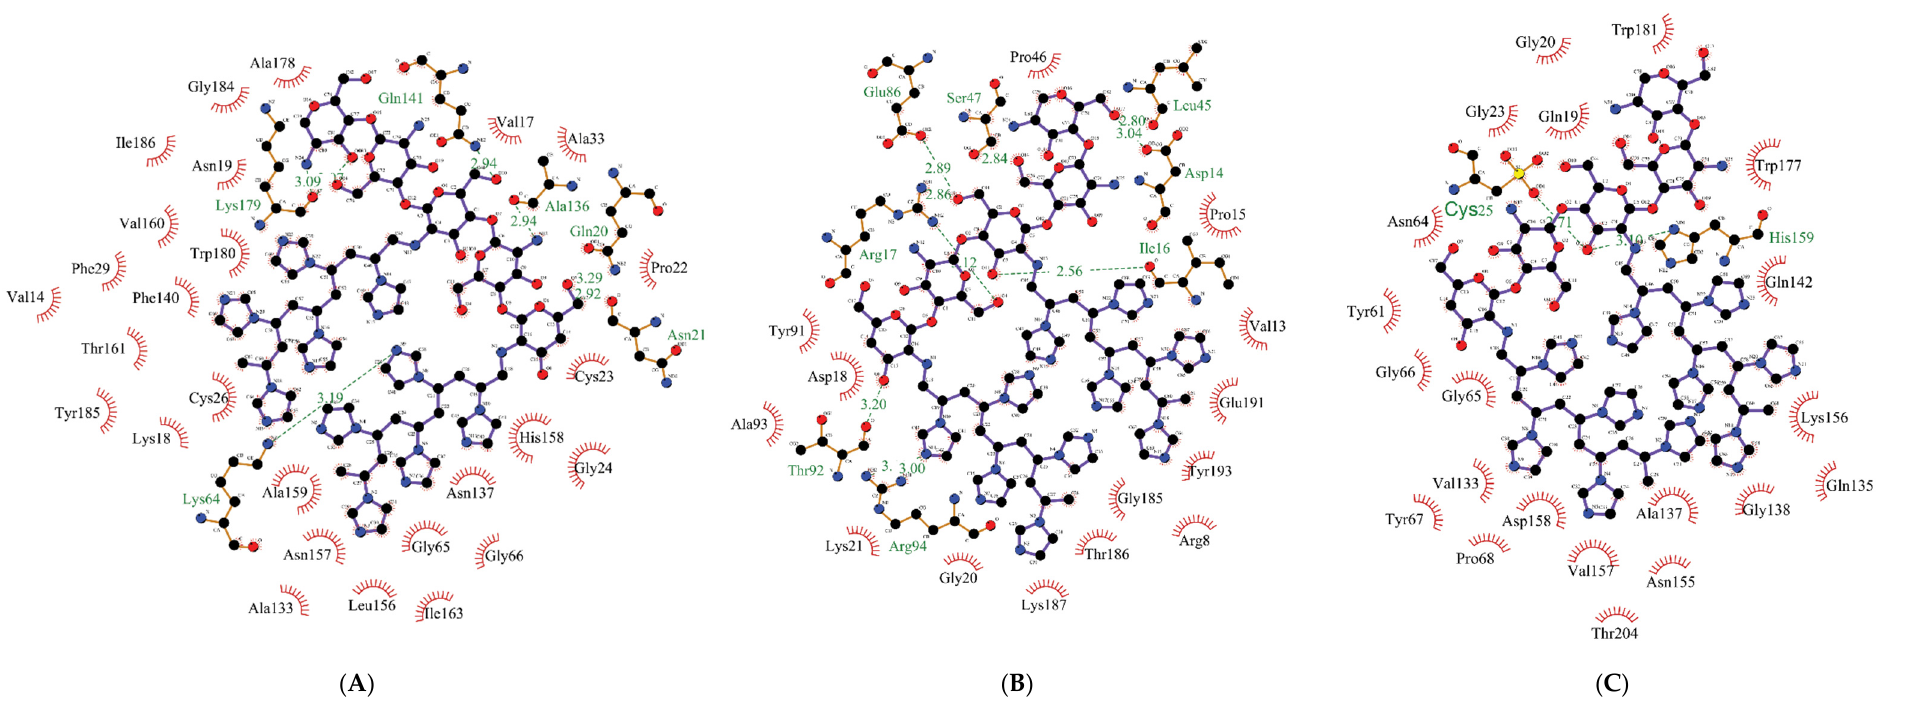
Figure 5. Bonds and interactions between the molecules of bromelain ( A ), ficin ( B ), papain ( C ) and Cht- g -PVI.